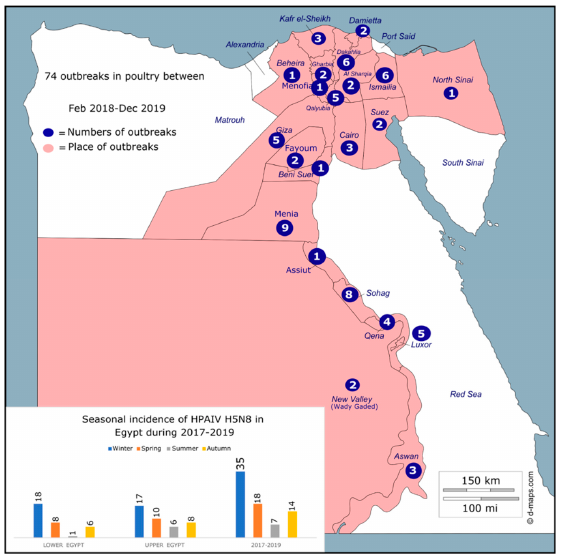
Figure 1. Temporal (graph) and geographic (map) distribution of outbreaks of HPAI H5N8 virus in poultry in Egypt, 2017- 2019. Map of Egypt is modified from https://d-maps.com/carte.php?num_car=25356&lang=en, accessed on 21 July